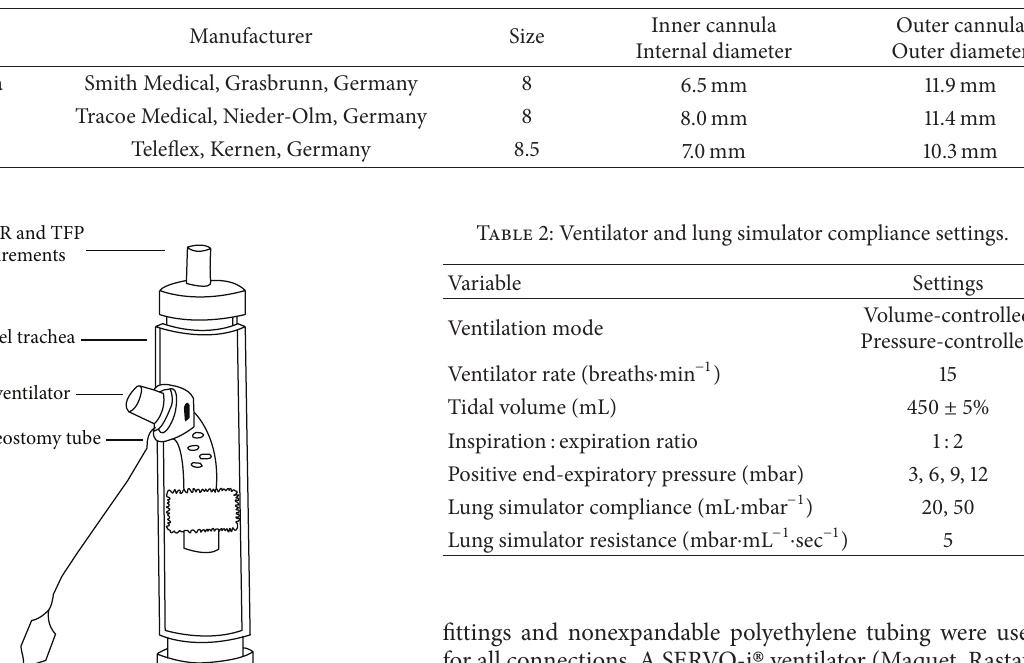
Table 1: Types and specifications of tracheostomy tubes tested.